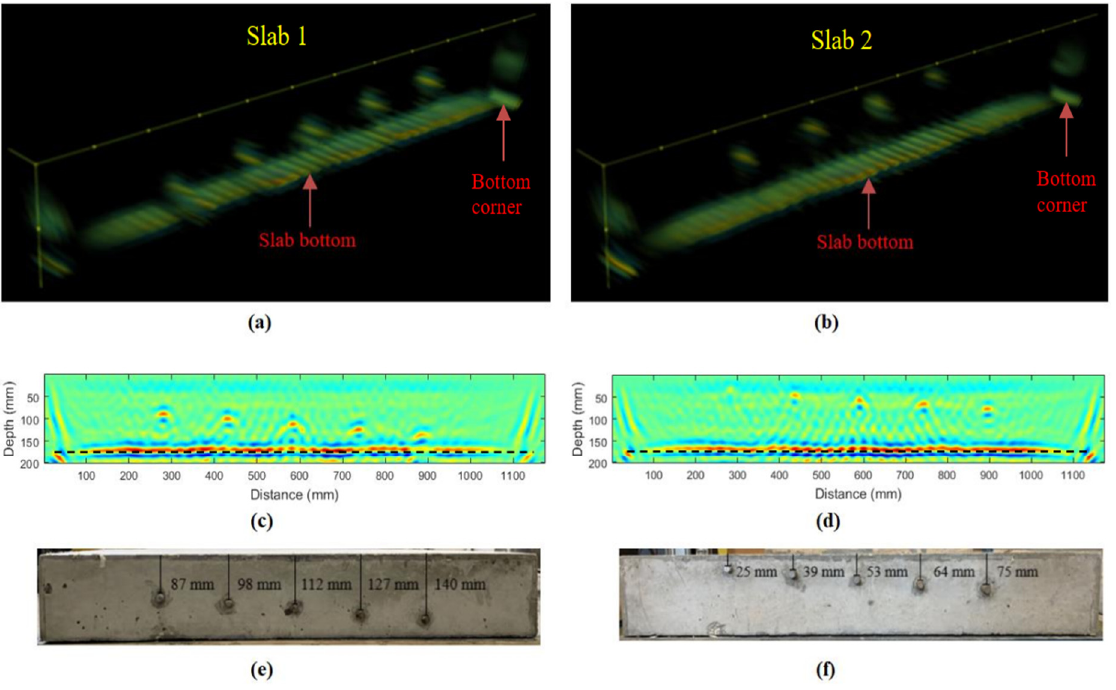
Figure 6. Imaging results for slab 1 and slab 2: ( a , b ) 3D images, ( c , d ) B-scan images, ( e , f ) side-view photos with ground-truth dimensions.